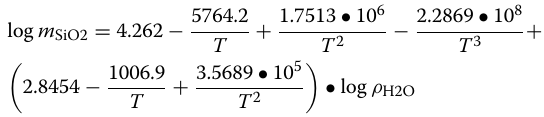
1 In the Q n -notation, the superscript, n, denotes the number of bridging oxy- gen in the silicate species. This means that the equivalent species for Q 0 , Q 1 , and Q 2 are SiO 4 , SiO 3.5 , and SiO 3 , respectively. It also means that the greater the value of n , the more polymerized is the silicate network of the Q n